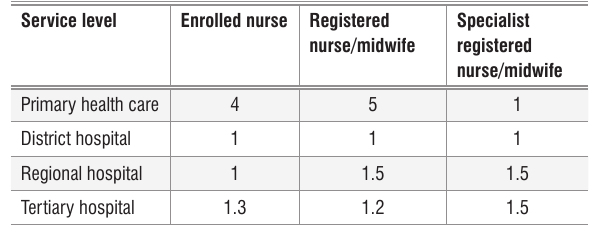
Suggested ratios for different categories of nurses at different levels of the health-care